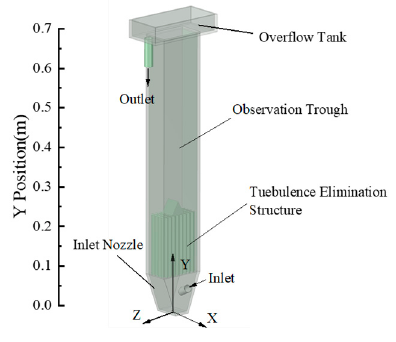
Figure 2. Schematic diagram of the concentration detection principle.